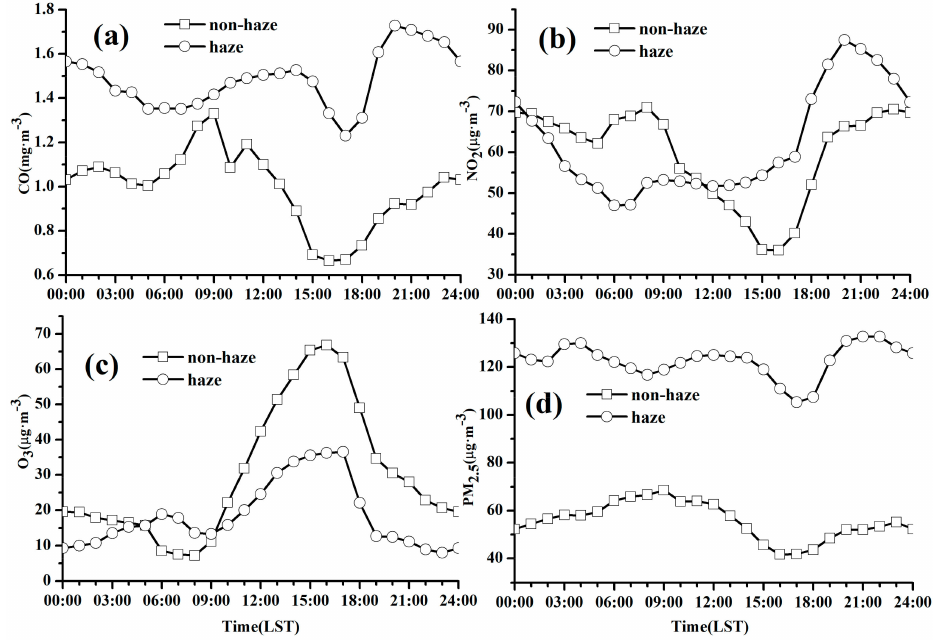
Figure 4. Diurnal variations of CO ( a ), NO 2 ( b ), O 3 ( c ) and PM 2.5 ( d